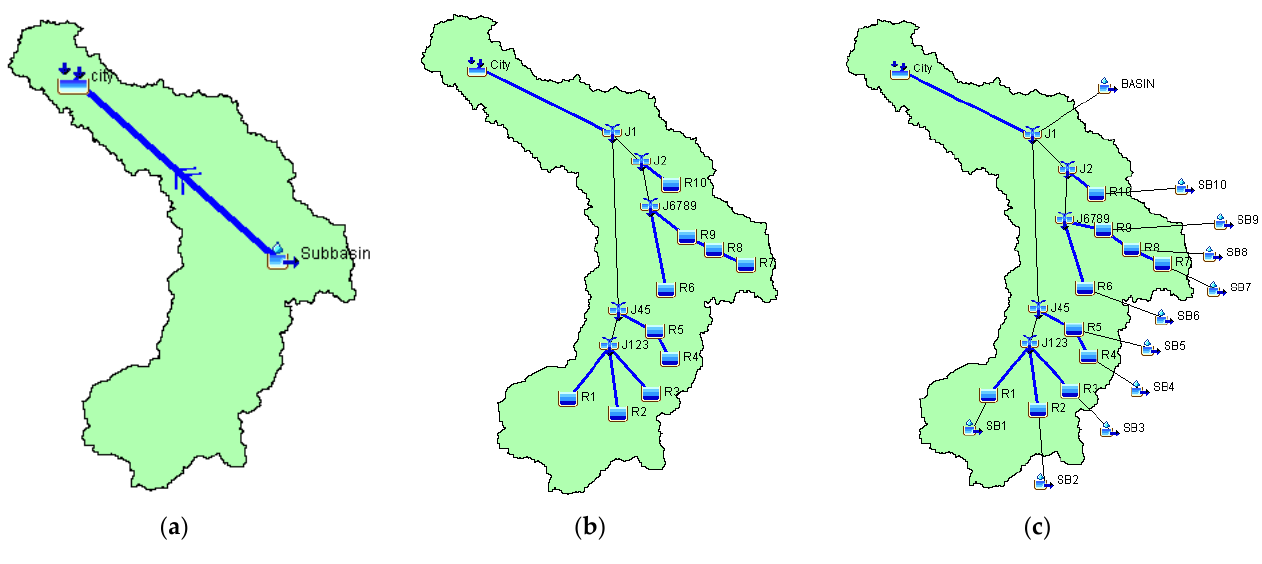
Figure 12. Hydrological modeling scheme in the HEC-HMS with the following scenarios: ( a ) scenario 01 and 02—isolated rainfall simulation, ( b ) scenario 03—isolated simulation of small dam’s rupture, ( c ) scenarios 04 and 05—complete simulation combining precipitation with dam failure. Table 4. Summary of the max discharge values from the HEC-HMS simulation.